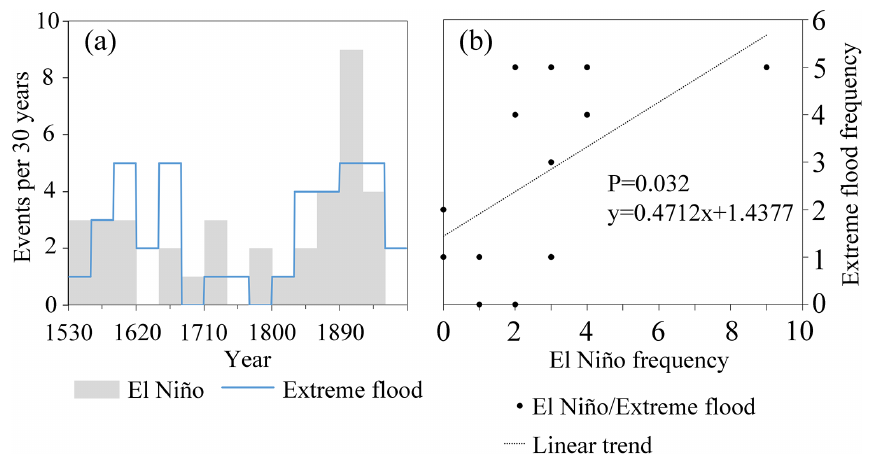
Figure 11. Correlation of extreme floods in the HRB and strong El Niño frequency (every 30 years) during 1530–1979. (a) Frequency distribution of extreme floods in the HRB and strong El Niño events; (b) correlation between frequencies of extreme floods and strong El Niño